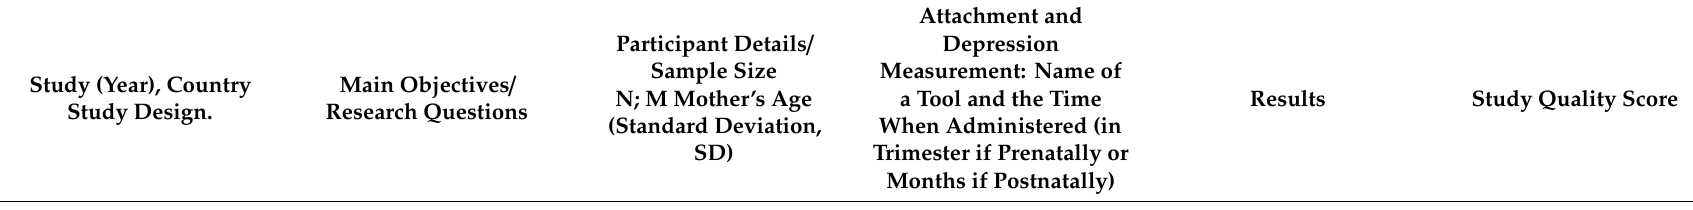
Table 1. Details of the studies measuring the impact of maternal depression on attachment security which used the clinical interview to diagnose depression.